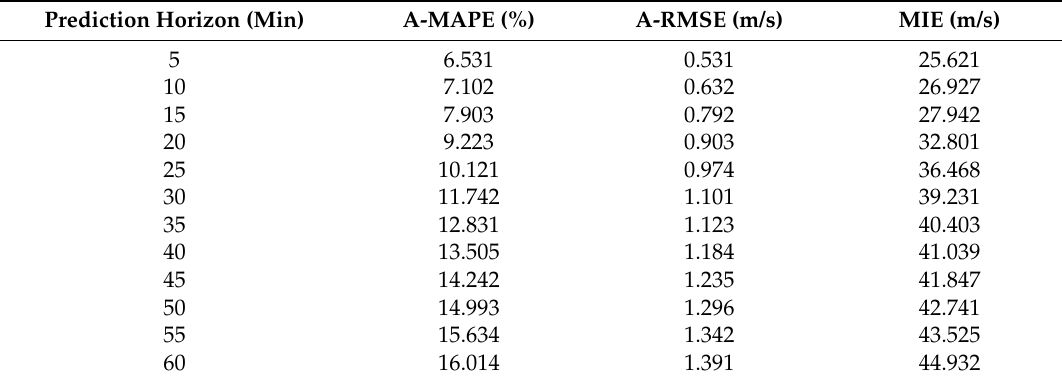
Table 5. Prediction Performance for local MLPs